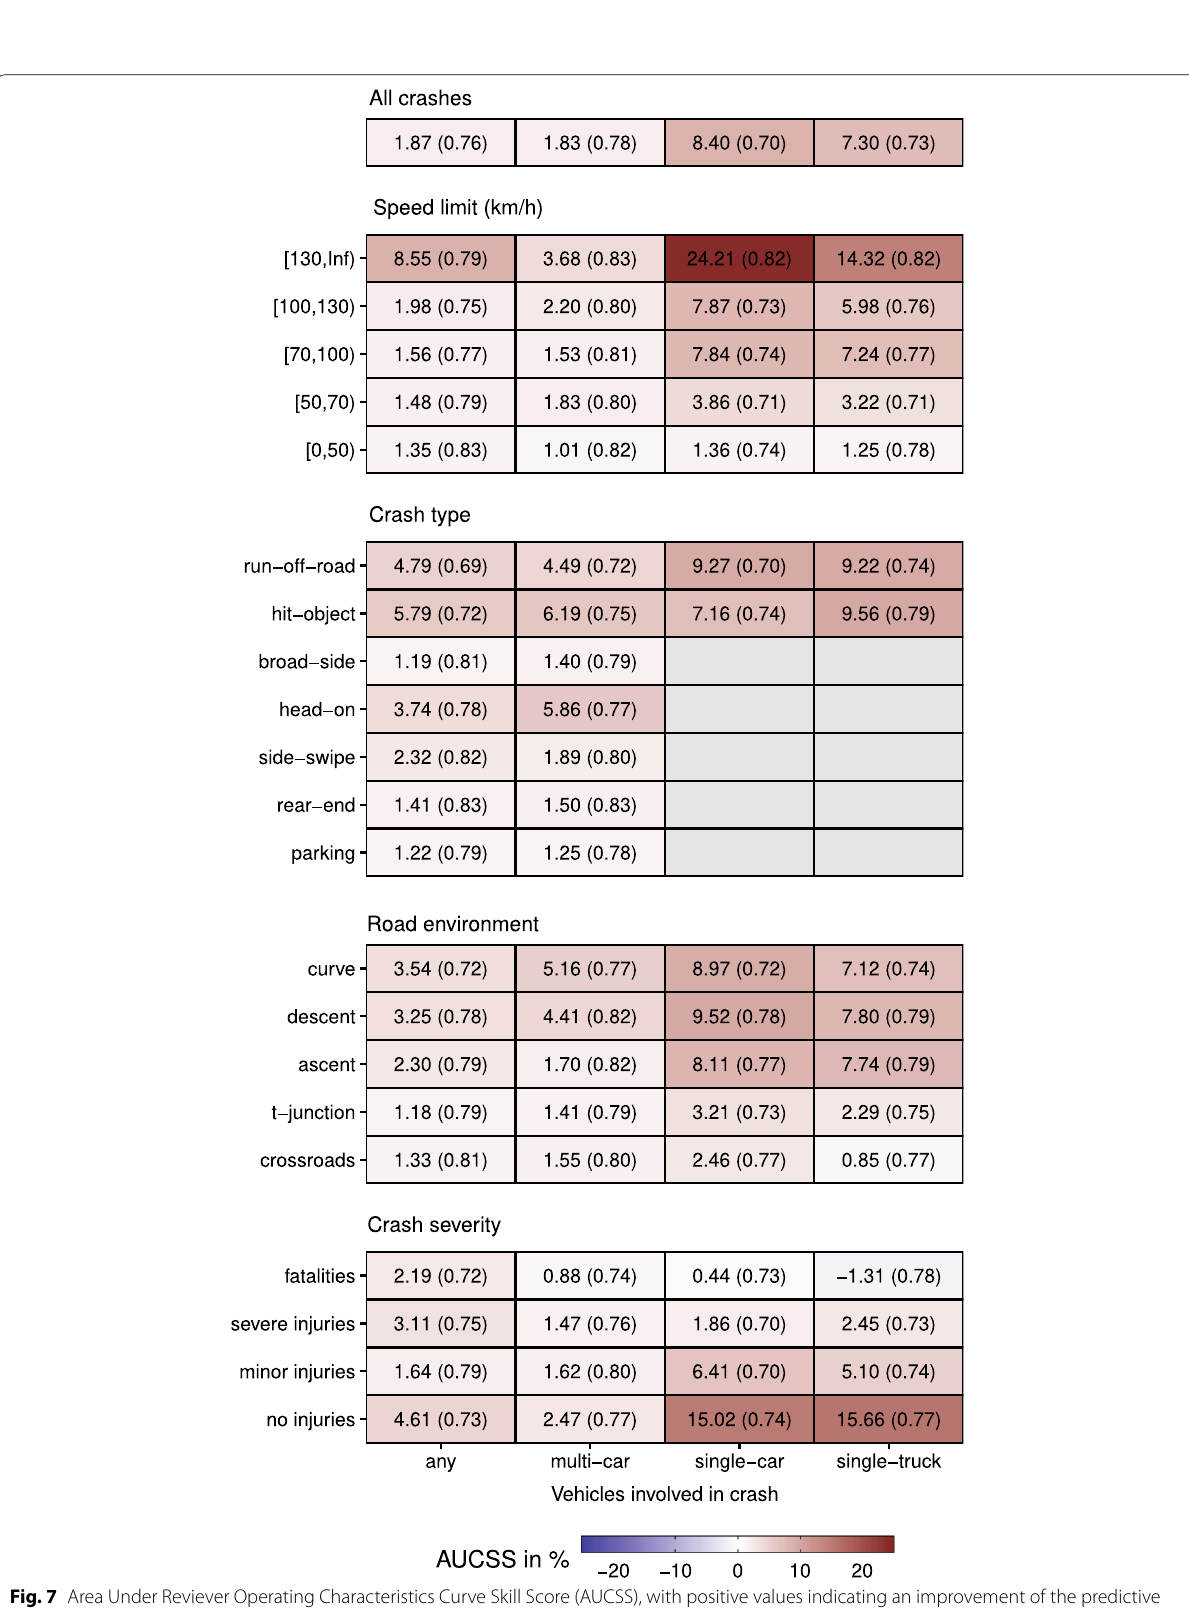
Fig. 7 Area Under Reviever Operating Characteristics Curve Skill Score (AUCSS), with positive values indicating an improvement of the predictive power if meteorological predictor variables are included in models for hourly probabilities of different crash types. The Area Under Reviever Operating Characteristics (AUC) of the models with meteorological predictor variables is given in